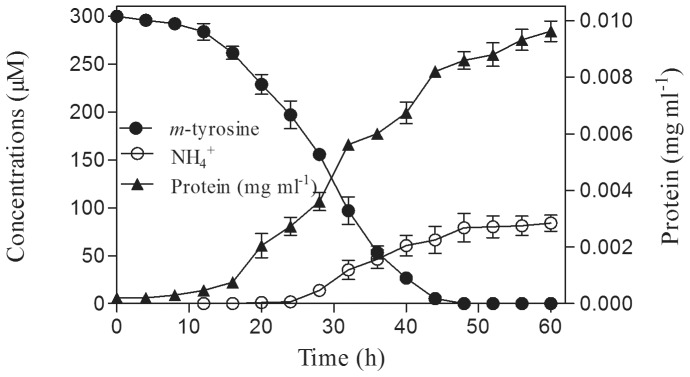
Growth of Bacillus aquimaris SSC5 on m-tyrosine as the sole carbon, nitrogen, and energy source.(•), m-tyrosine; (▴), total protein; (○), NH4
+. Values are presented as arithmetic mean of data obtained from experiments carried out in triplicate; error bars represent standard deviation.